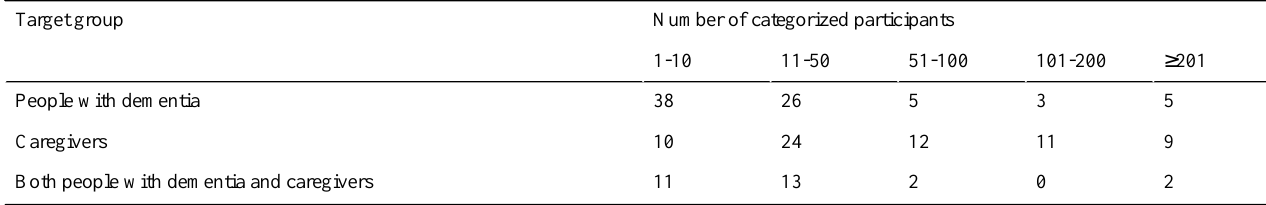
Table 2. Absolute number of publications by number of participants (n=175).